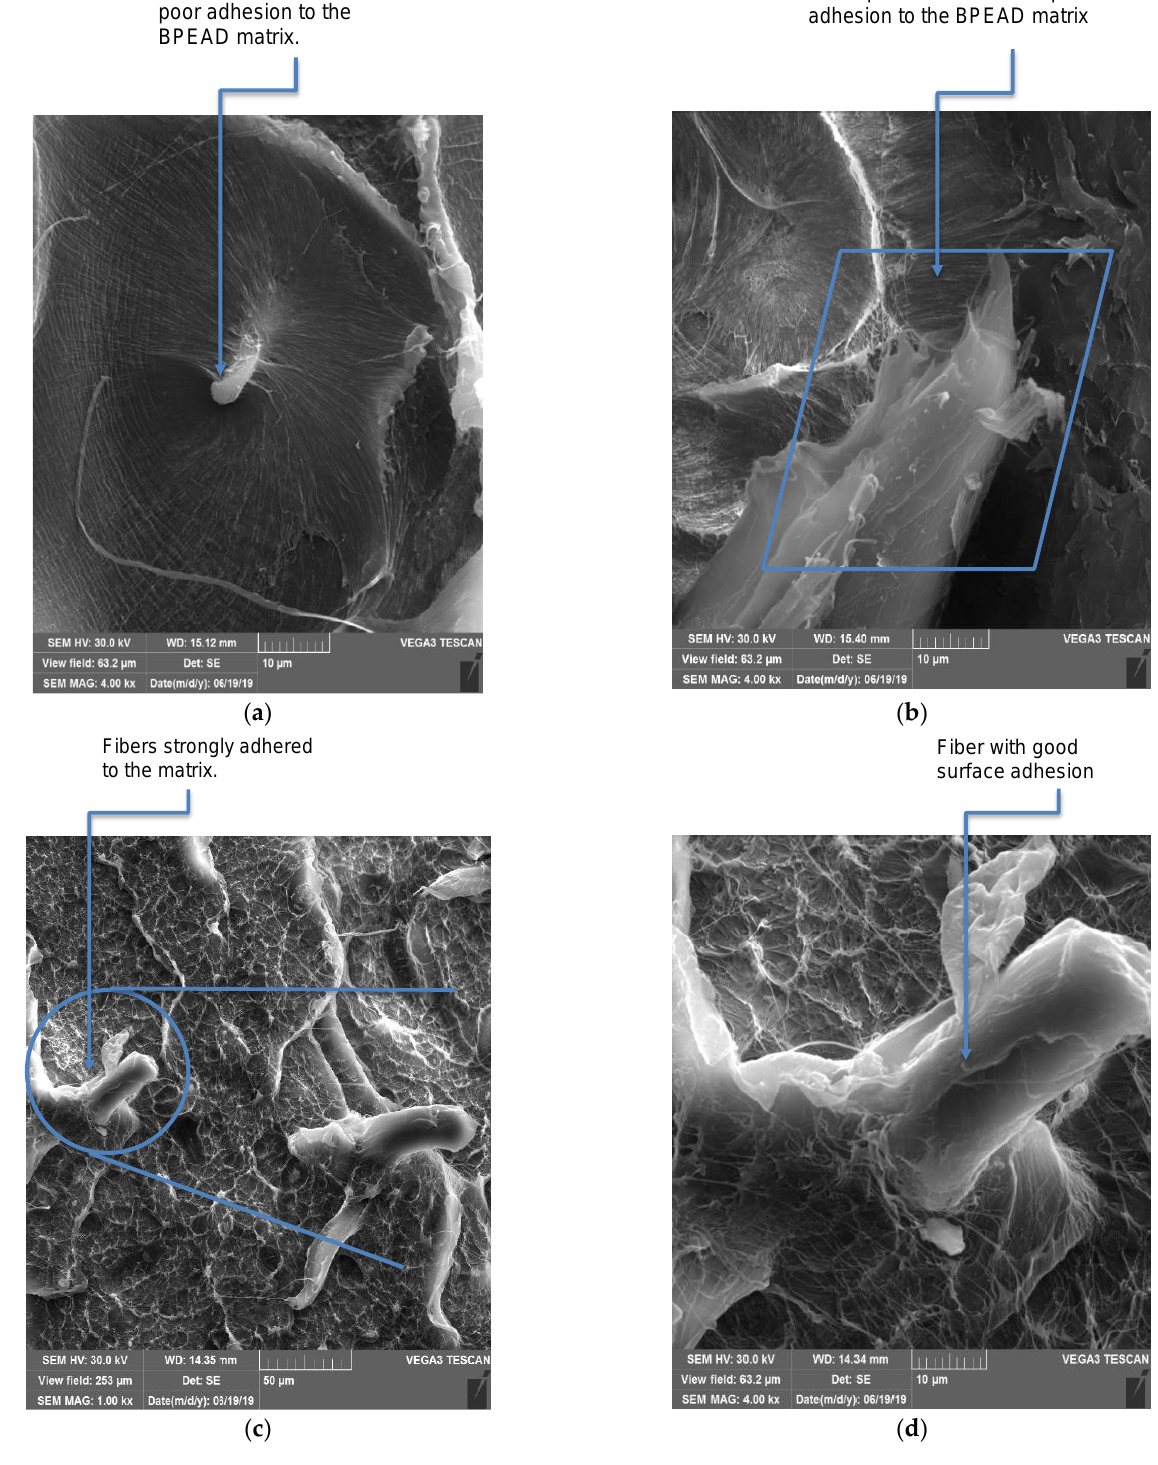
Figure 7. SEM micrographs of biocomposites: ( a , b ) B-HDPE/PE-g-MA/CF3 and ( c , d ) B-HDPE/PE-g-MA/CF5.